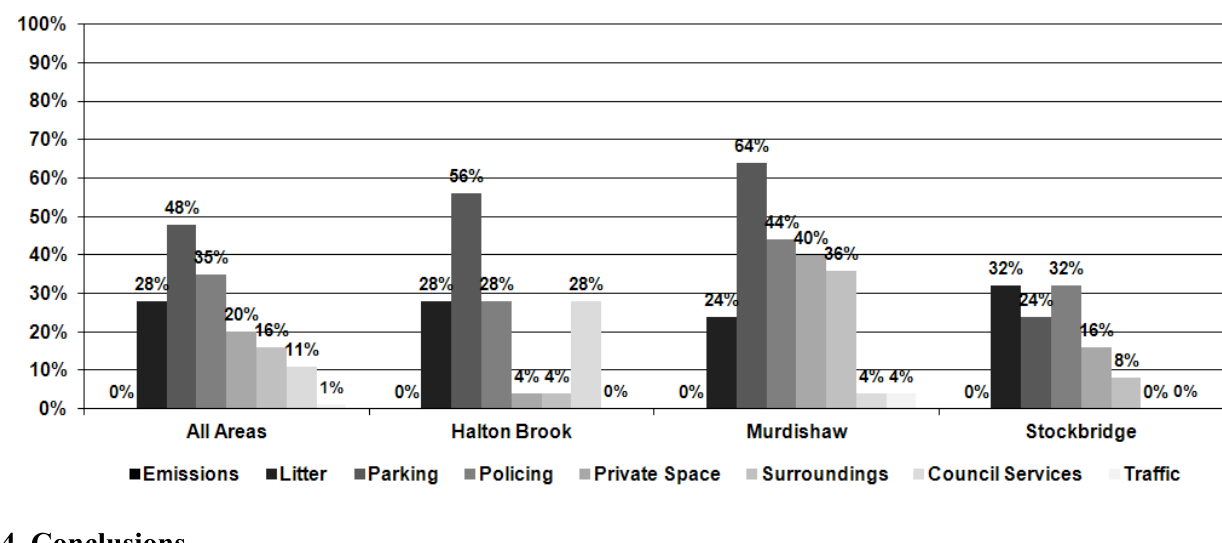
Figure 13. Other important issues raised by